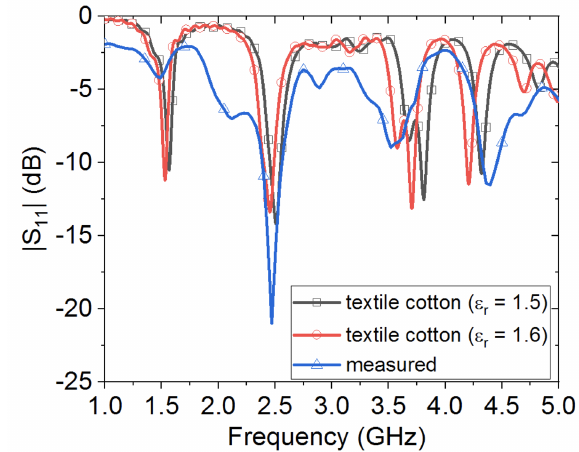
Figure 19. Simulated versus measured reflection coefficient results for the wearable loop antenna with the HIS structure.